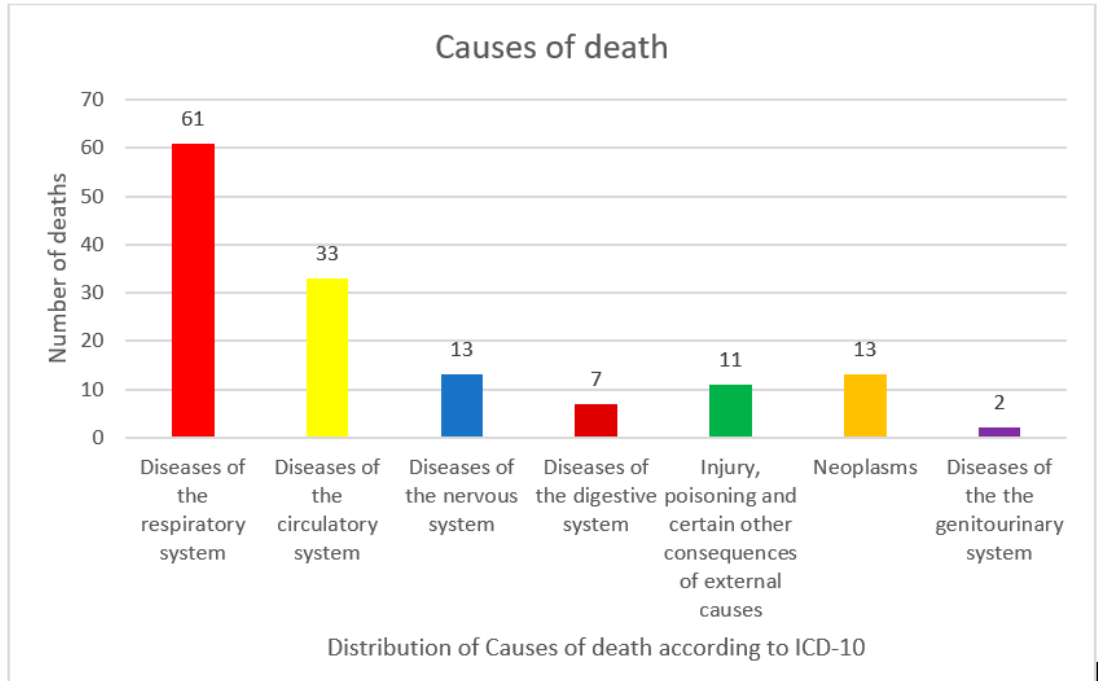
Figure 2. The excess mortality from Covid-19 in March and April 2020 in comparison with the number of deaths reported in the same period in 2018 and 2019 at the “San Giuseppe Moscati” Hospital in Avellino (Italy).